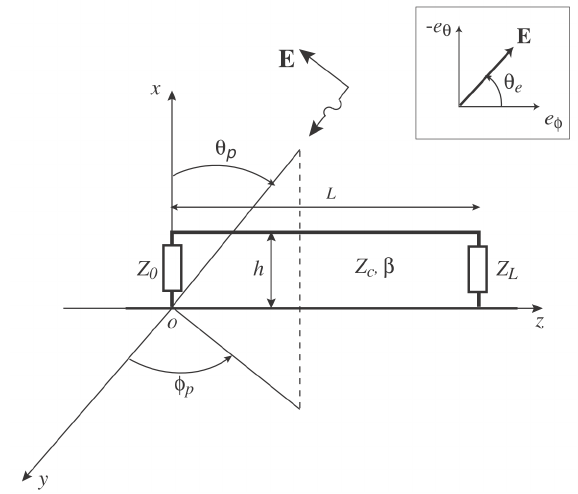
Figure 3: Transmission line illuminated by a plane wave